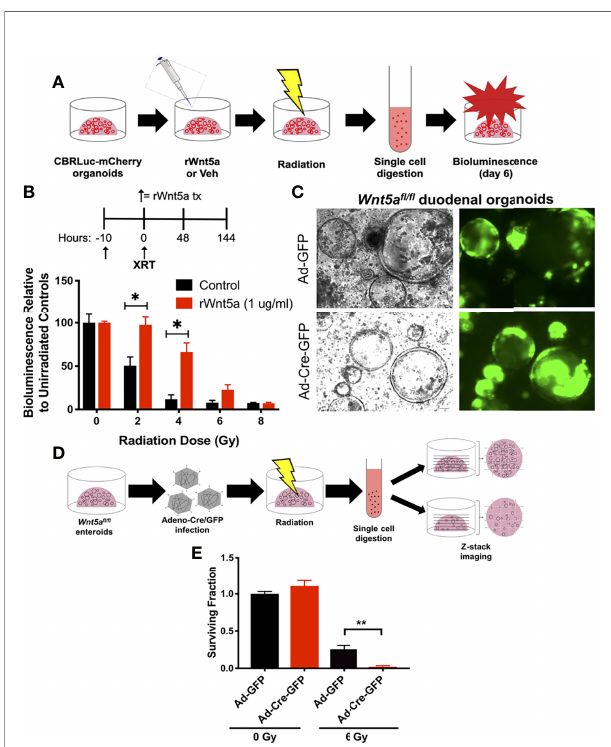
FIGURE 5 | Wnt5a mediates HIF2-associated radioprotection of the small intestine. (A) Schematic representation illustrating how spheroid formation assays were performed using murine duodenal CBRLuc-mCherry reporter organoids to test whether rWnt5a radioprotects. (B) CBRLuc-mCherry organoids treated with vehicle (PBS) or 1 m g/ml rWnt5a for 10h were exposed to the indicated doses of ionizing radiation. Bioluminescence was measured 6 days post-radiation (n = 3 per group). (C) Wnt5a fl / fl duodenal organoids were transduced with Adeno-Cre-GFP or control Adeno-GFP to generate Wnt5a knockouts. Representative bright fi eld and GFP images are shown. (D) Schematic representation illustrating how spheroid formation assays were performed using Wnt5a fl / fl duodenal organoids to test whether Wnt5a is necessary for crypt regeneration following radiation. (E) Wnt5a fl / fl duodenal organoids infected with Adeno-Cre-GFP or Adeno-GFP were exposed to the indicated doses of ionizing radiation. Z-stack images were stitched and organoids larger than 150 m m in diameter were quanti fi ed 6 days post- radiation and mean surviving fraction is plotted (n = 3 per group). All error bars represent mean ± SEM. * P < 0.05, ** P < 0.01, by Student ’ s t